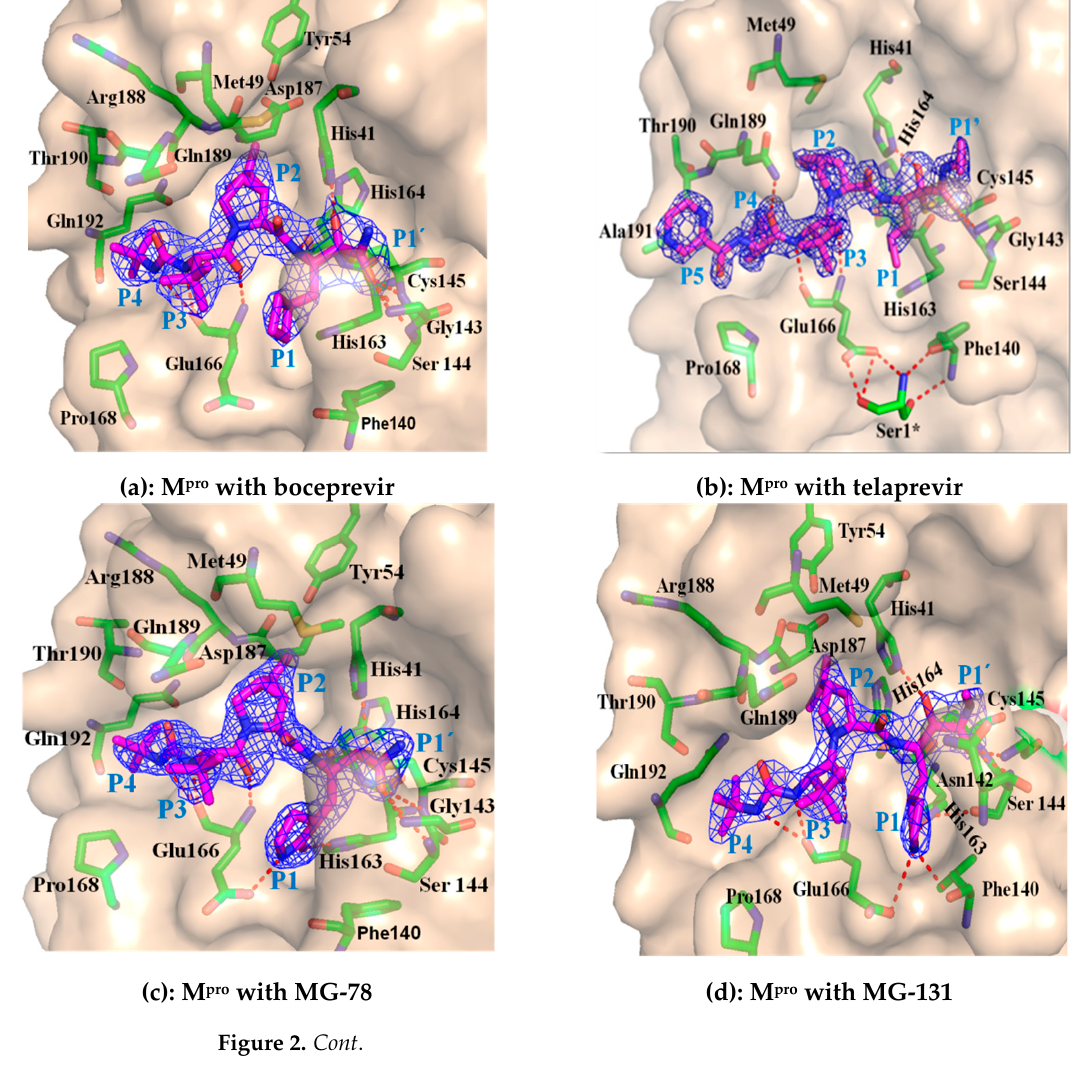
(f): CVB3 3C pro with MG-78 Figure 2. Crystal structures of M pro in complex with boceprevir ( a ), telaprevir ( b ), MG-78 ( c ), and MG-131 ( d ). Crystal structure of EV-A71 3C pro ( e ) and CVB3 3C pro ( f ) in complex with MG-78. The 2Fo-Fc OMIT maps are contoured at 1.5 σ , except for panels a and f, which are contoured at 1.0 σ . 2.8. P1 Residue The main-chain nitrogen of the inhibitors’ P1 building block donates a hydrogen bond to the carbonyl oxygen of His164, an interaction found with nearly all pep- tidomimetic M pro inhibitors. MG-78 and MG-131 make ideal hydrogen bonds to the an- choring points in the S1 pocket, His163, Glu166, and Phe140. In more detail, there is a strong hydrogen bond between the lactam oxygen and His163 N ε 2, and a three-center